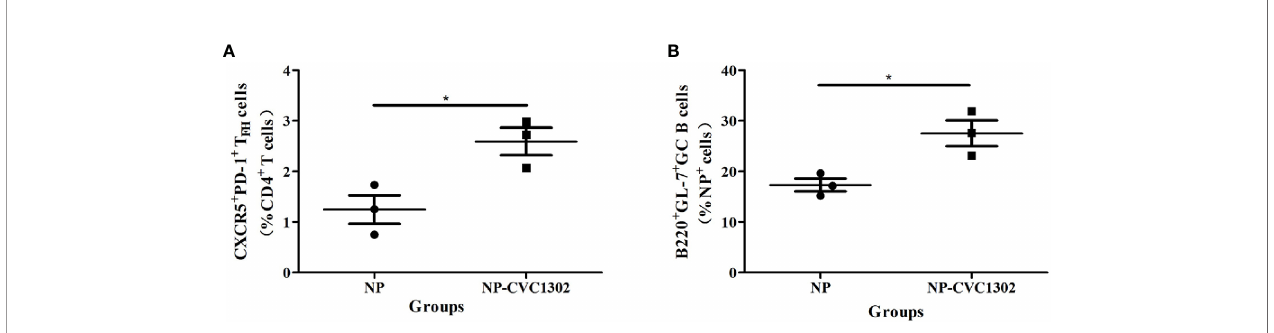
FIGURE 2 | NP + GC B cells and TFH percentages in immunized mice. (A) Percentages of NP + GC B cells and (B) TFH in mice immunized once with Marcol 52, NP, or NP-CVC1302. Samples were collected at 14 dpi. Values show the mean ± SEMs of 3 draining LNs from 3 mice per treatment group. * P <